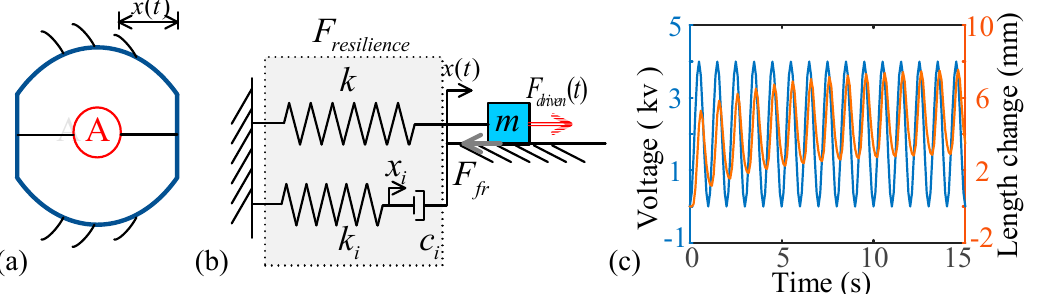
Figure 1. A model schematic diagram and the deformation response of a body segment from the earthworm-like robot driven by a dielectric elastomer actuator. ( a ) A diagram of the body segment deformation. F driven ( t ) is the ultra-low frequency excitation. Gray represents the initial state of the segment, and blue represents the actuation state of the segment. “A” indicates the actuator; gray indicates the inactive state, and red indicates the active state. ( b ) A dynamic model of the body segment. ( c ) The response of the body segment under excitation by sinusoidal excitation voltage. The yellow line represents the simulated body segment length deformation, and the blue line represents the excitation voltage.